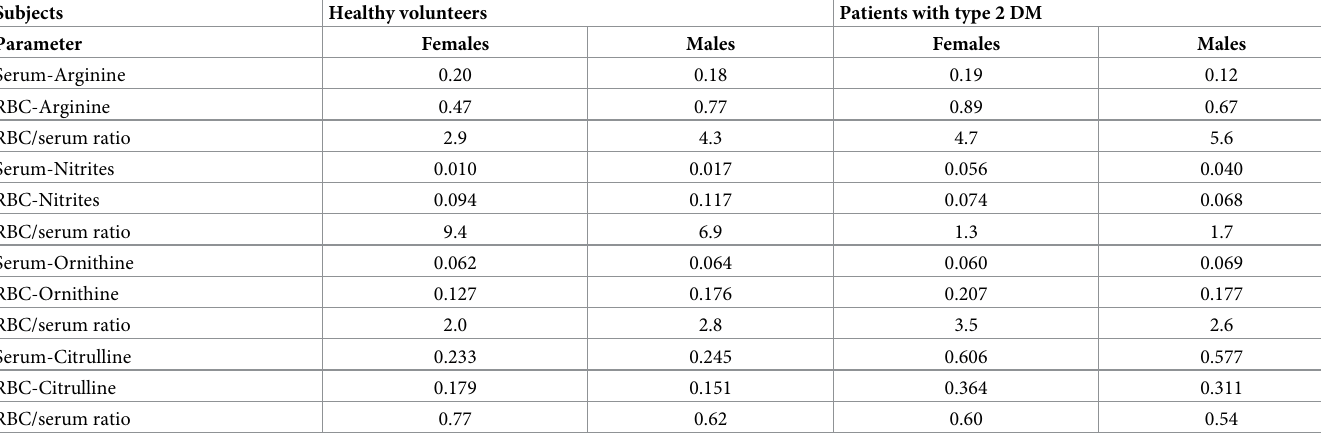
Table 2. RBC and serum levels of nitrogen-related metabolites and their ratios in female and male patients with type 2